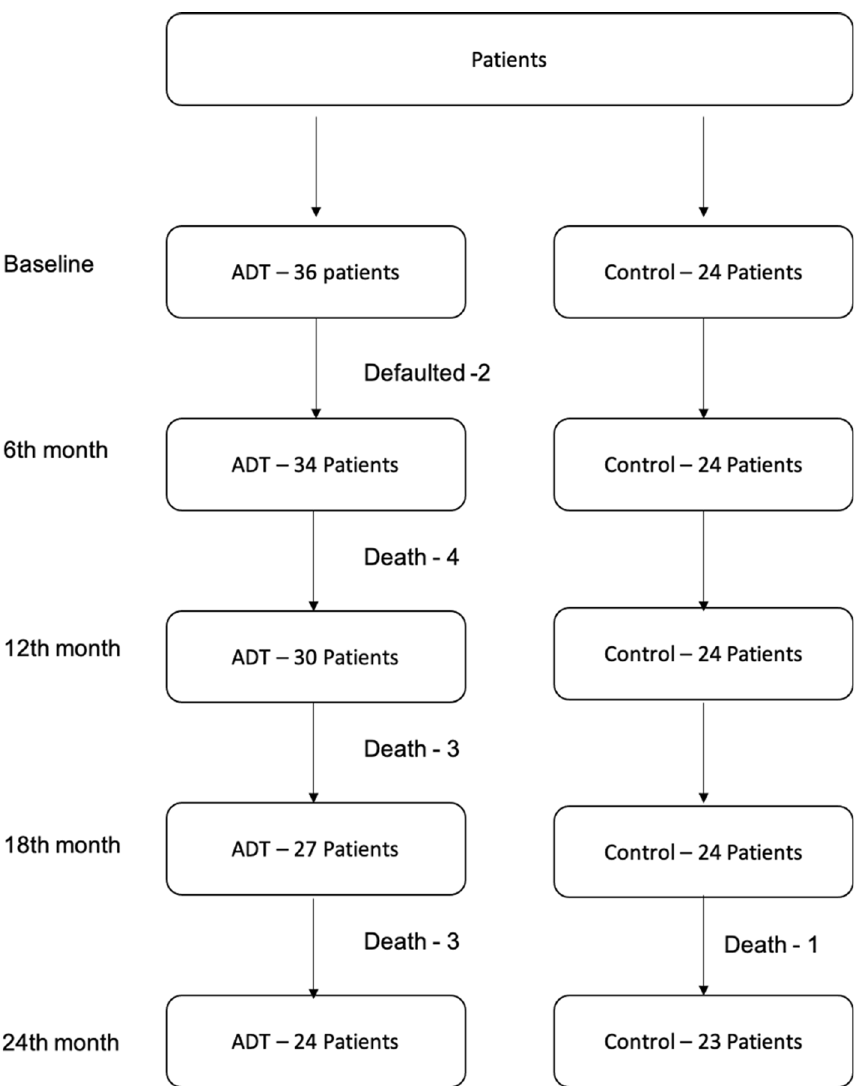
Figure 1. Flowchart of patient follow-up